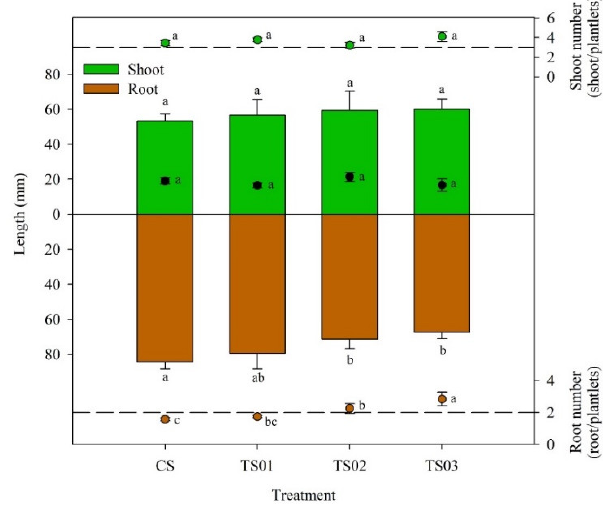
Figure 2. Shoot regeneration number, root induction number, and length of shoots and roots of Hylocereus polyrhizus ‘Da Hong’ grown on Murashige and Skoog (MS) medium supplemented with α-naphthaleneacetic acid (NAA) alone. Treatments: CS, control; TS01, 0.05 mg/L NAA; TS02, 0.10 mg/L NAA; TS03, 0.20 mg/L NAA. Mean ± SE ( n = 3, 5 segments per replicate). Means followed by different letters near the column and circle are significantly different at p = 0.05 using Fisher’s protected LSD test. The black circle inside the green column indicates the average shoot length.